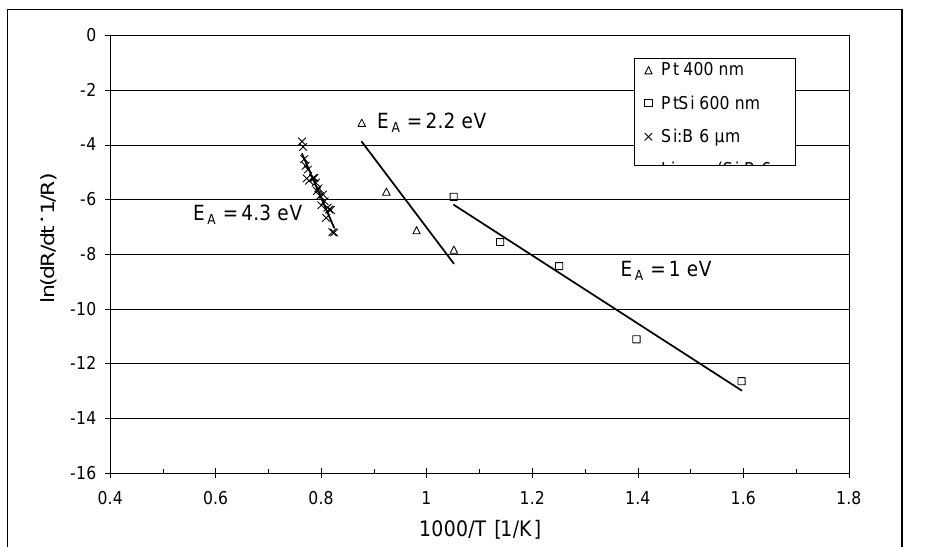
:Sb heaters exhibited even 2 could not be a